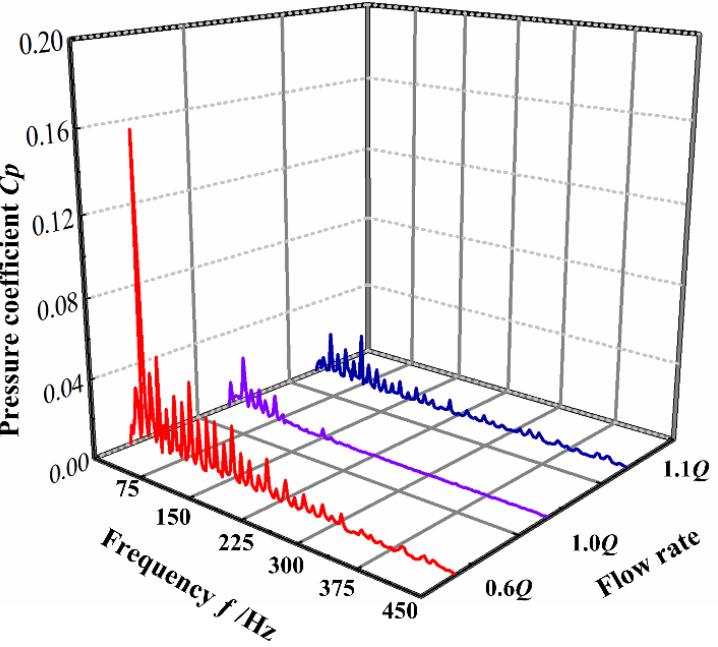
Figure 16. Frequency domain diagram of point DP4 at three typical flow rate conditions.